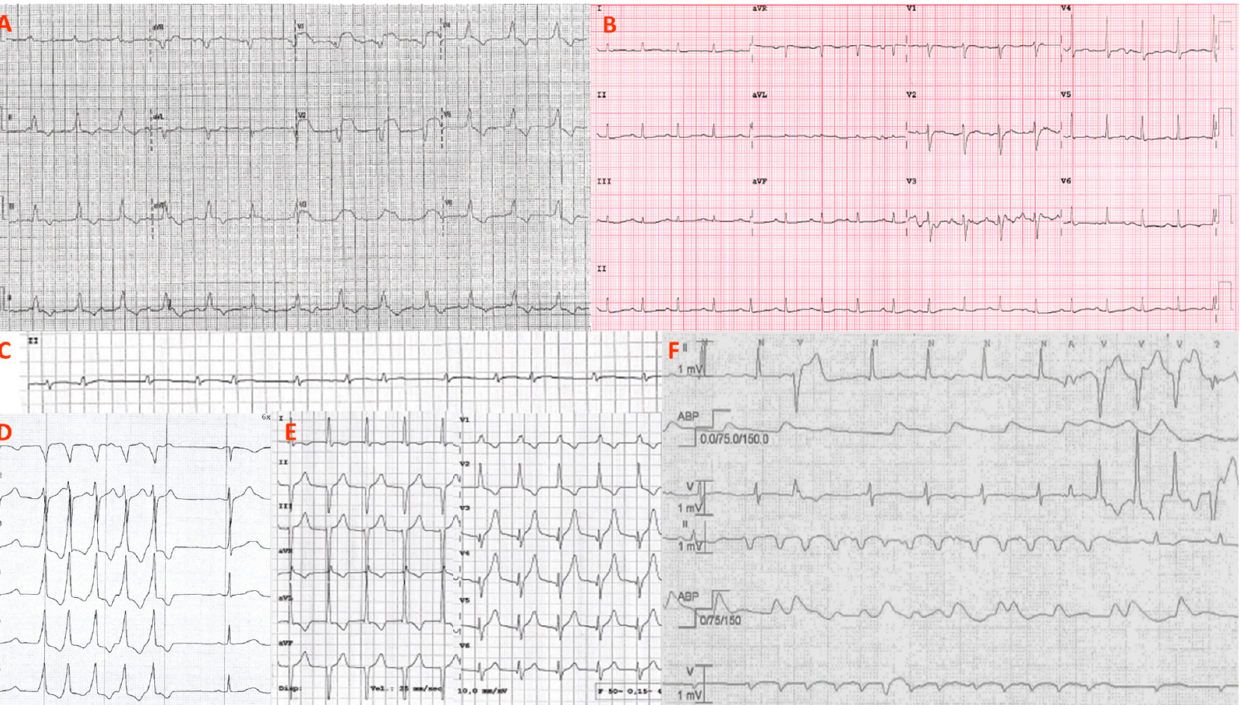
Figure 1. ECG and arrhythmias. Representative ECGs and arrhythmias from the patient series (P1–P7) are shown. ( A ) Atrioventricular dissociation with huge anterior ST elevation (P7); ( B ) sinus tachycardia with low QRS voltages and diffuse repolarization abnormalities (P2); ( C ) paroxysmal atrial fibrillation detected by ICU telemonitoring (P7); ( D ) nonsustained ventricular tachycardia (P4); ( E ) transitory, self-limited, accelerated junctional rhythm (P1); ( F ) polymorphic and irregular nonsustained ventricular tachycardias during ICU stay (P5). ICU = intensive care